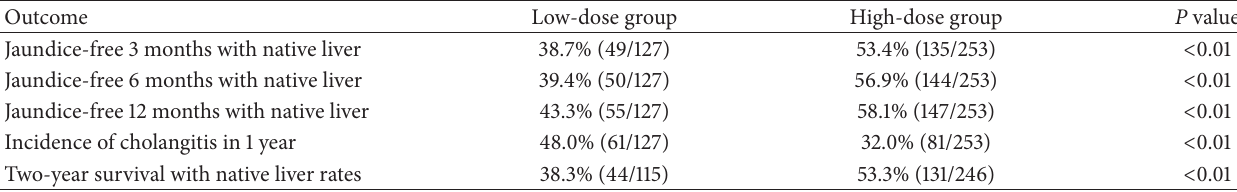
Table 2: Outcome of children receiving low-dose steroid and high-dose steroid.